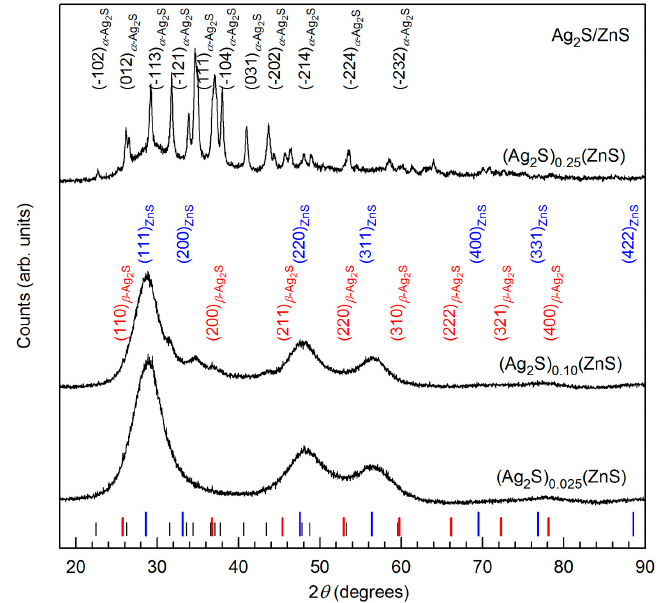
Figure 19. XRD patterns of core-shell Ag 2 S@ZnS (Ag 2 S/ZnS) heteronanostructures: short black, middle red, and long blue ticks indicate reflections from monoclinic (space group P2 1 /c) α -Ag2S acanthite, cubic (space group Im 3 m ) β -Ag 2 S argentite, and cubic (space group F 43 m ) ZnS sphalerite, respectively.